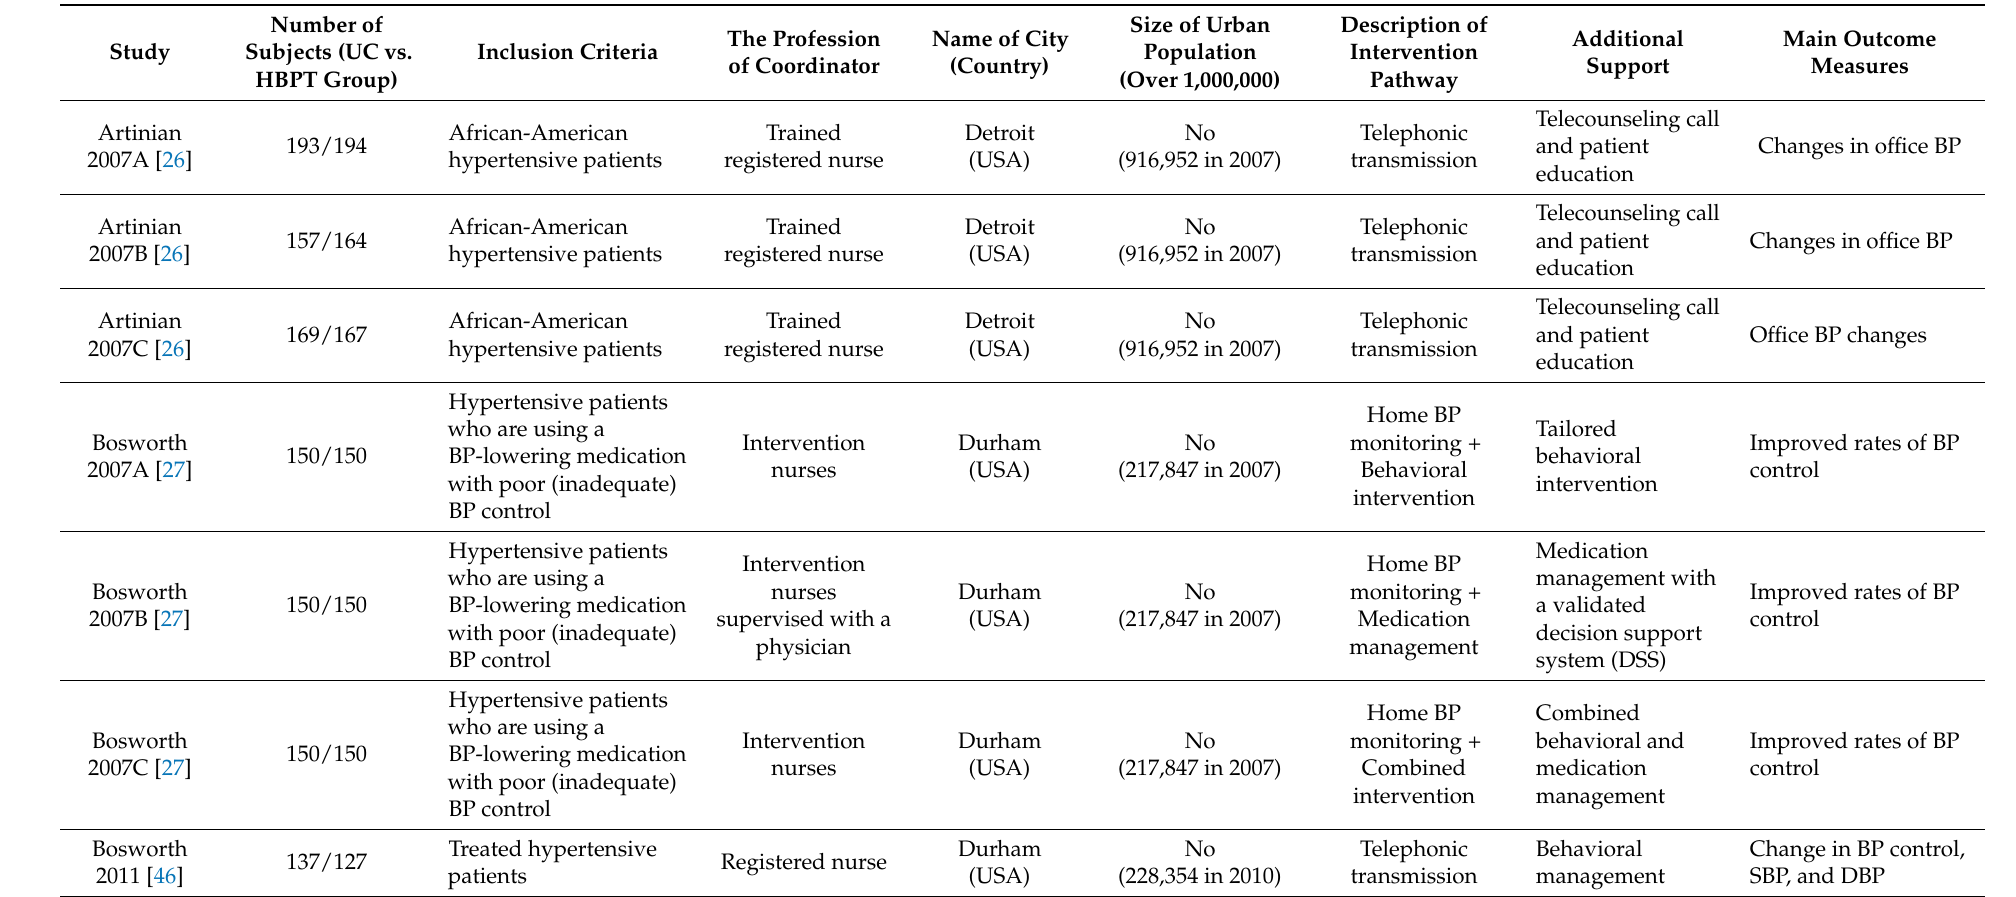
Table 1. Characteristics of included individual